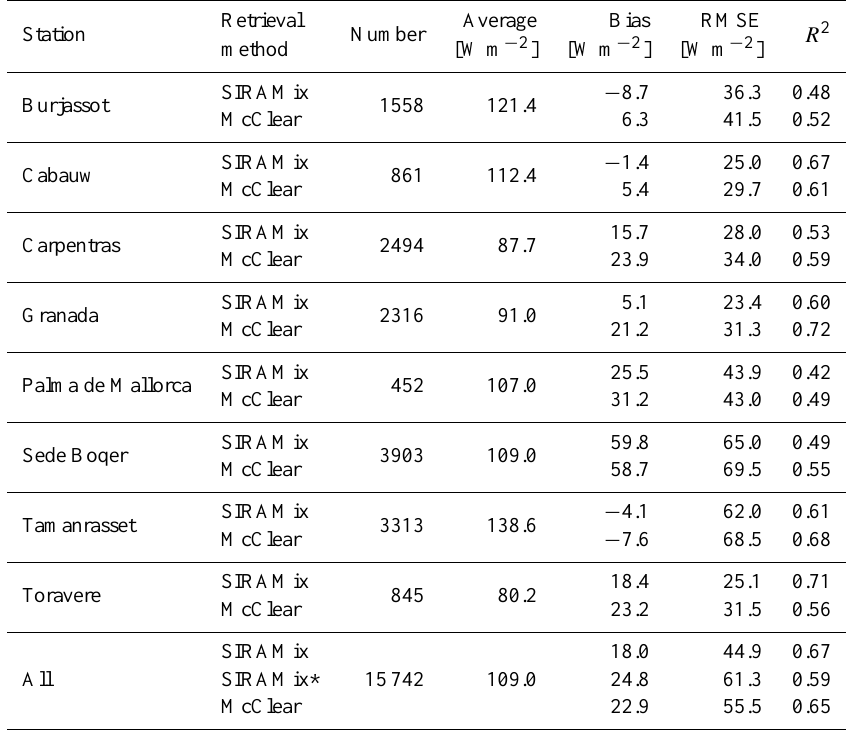
Table 5. Idem to Table 4 for diffuse irradiance. Measurements of diffuse DSSF are not available for the station in Evora. Station